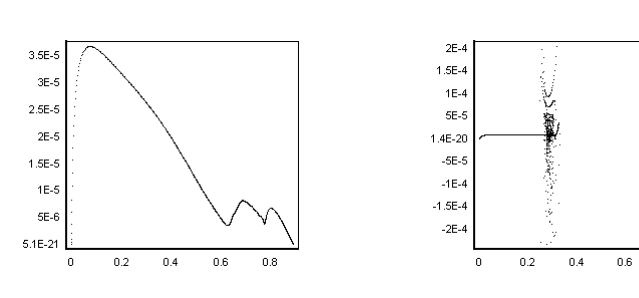
Figure(cid:5)(cid:1)Phasediagramatx(cid:14)(cid:15)(cid:0)(cid:2)Figure(cid:6)(cid:1)Phasediagramatx(cid:14)(cid:15)(cid:0)(cid:16)